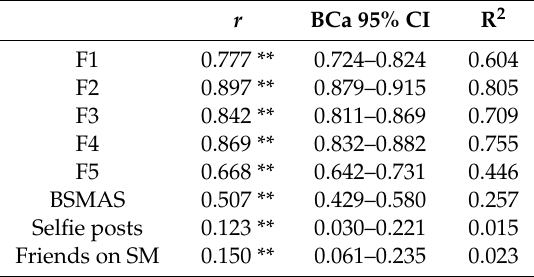
Table 3. Bootstrapped correlation matrix with 95% BCa confidence interval between the five dimensions of the SBS, BSMAS, number of selfies posts and number of friends on social media (Facebook, Twitter and Instagram). r BCa 95% CI R 2